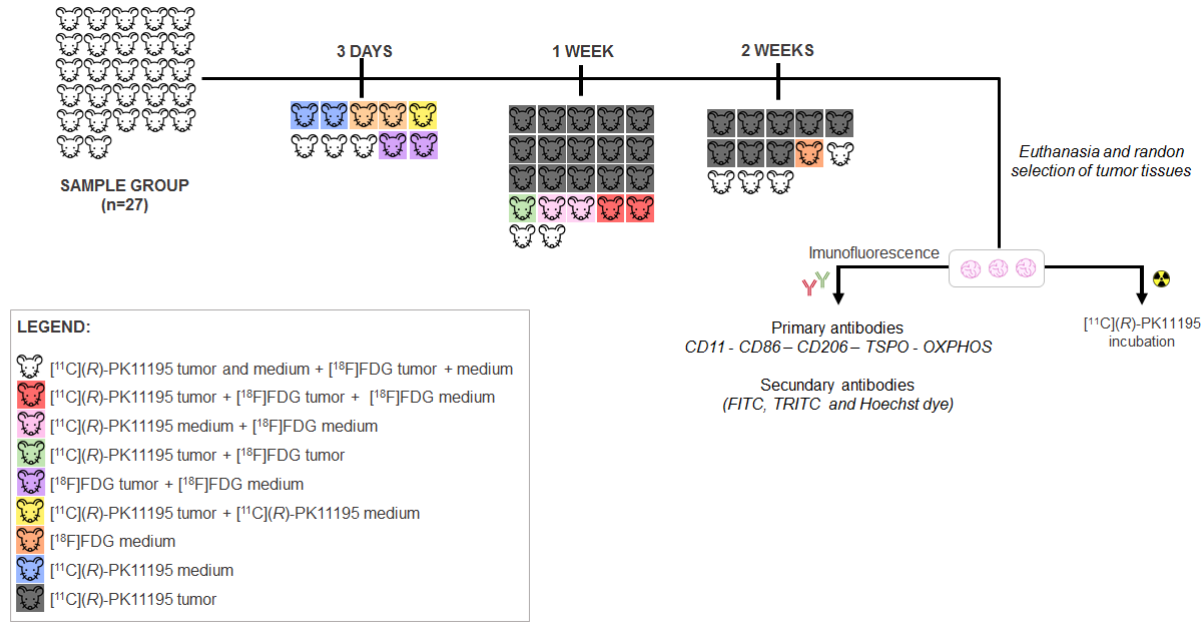
Figure 1. Experimental study design and the divisions/sub-groups at each time point, illustrated by different colors. Note: As the main scientific question was related to the [ 11 C]( R )-PK11195 uptake in the tumor, the sample size for this tracer was bigger than for [ 18 F]FDG, as higher variations in the results were expected due to tumor growing heterogeneity.